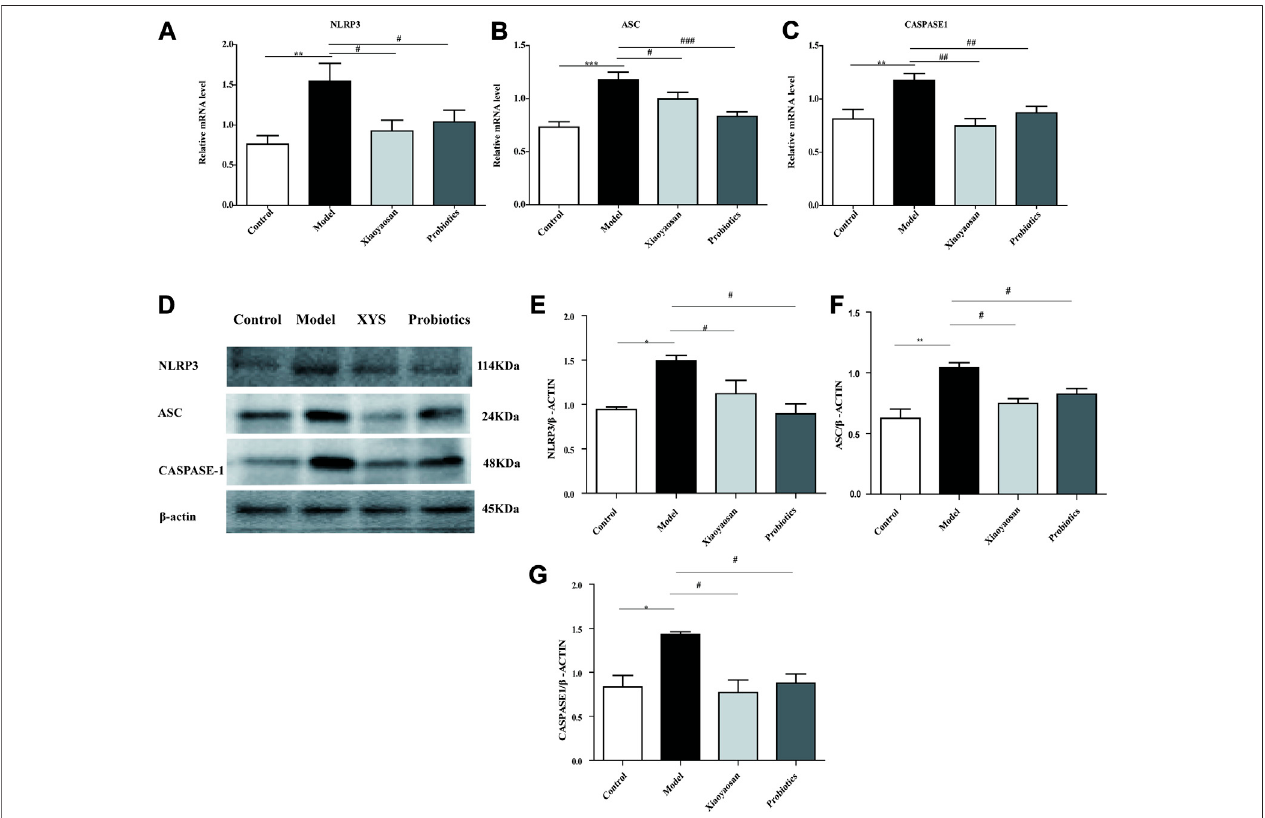
FIGURE 5 | Effects of Xiaoyaosan on the NLRP3-ASC-CASPASE-1 pathway in the colon. (A) NLRP3mRNA in colon ( n (cid:2) 6). (B) ASCmRNA in colon ( n (cid:2) 6). (C) CASPASE-1mRNAin colon( n (cid:2) 6). (D) Expressionof NLRP3, ASC, CASPASE-1protein incolon ( n (cid:2) 4). (E) NLRP3 protein in colon ( n (cid:2) 4). (F) ASC protein incolon ( n (cid:2) 4). (G) CASPASE-1 protein in colon ( n (cid:2) 4). Data are expressed as the mean ± SEM. * p < 0.05, ** p < 0.01 vs. the control group; # p < 0.05, ## p < 0.01 vs. the antibiotic- induced model